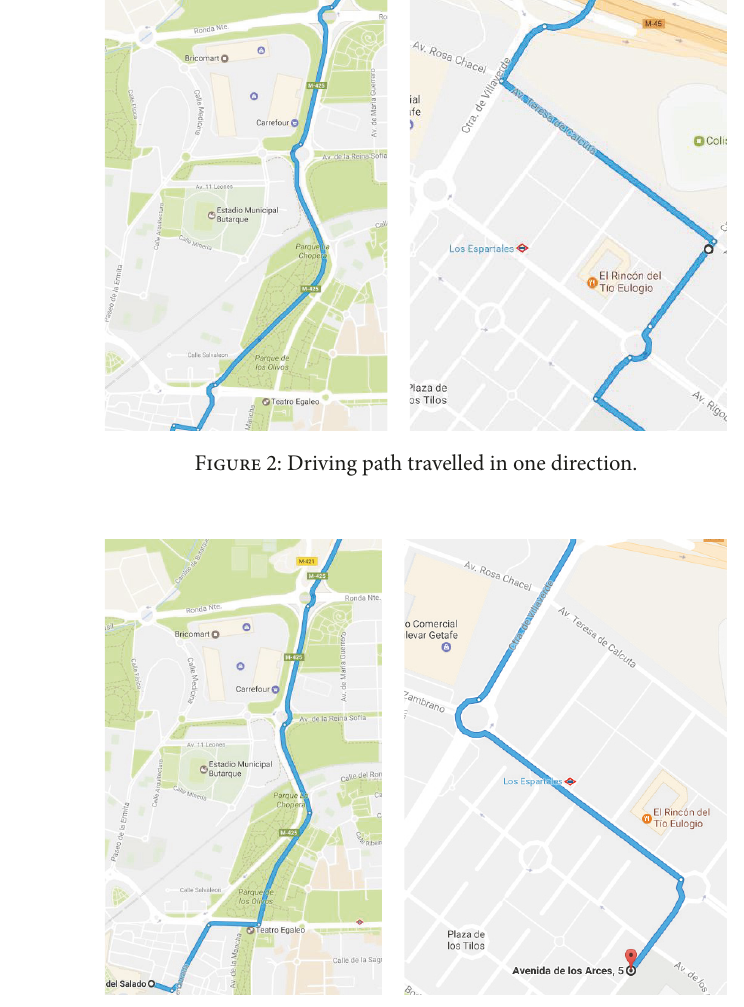
Figure 3: Driving path travelled in the opposite